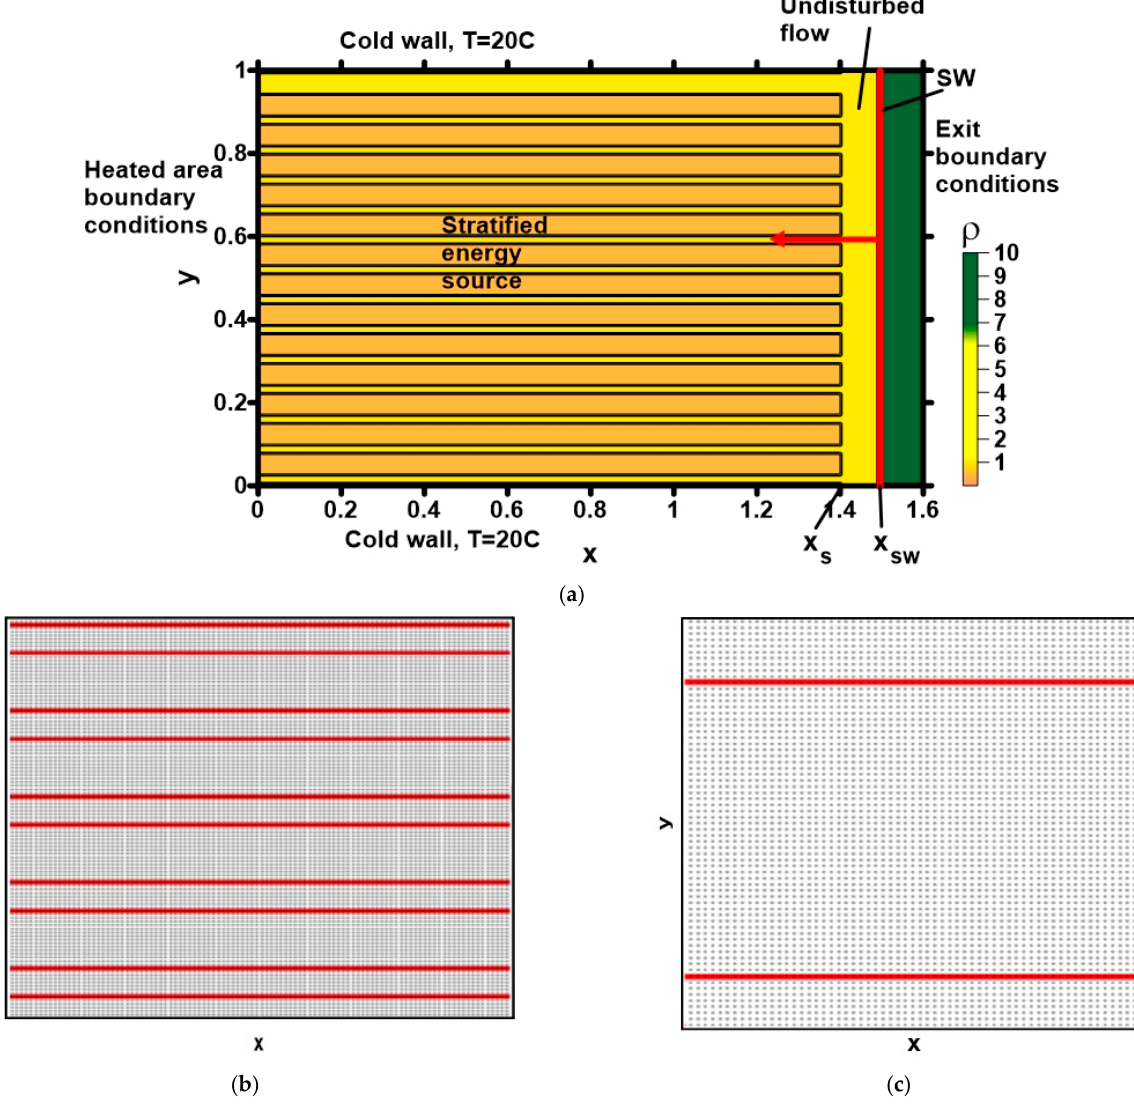
Figure 1. Schematic of the problem statement ( a ); location of the stratified energy source on difference grid (enlarged) ( b ); location of one layer of on difference grid (enlarged) ( c ).